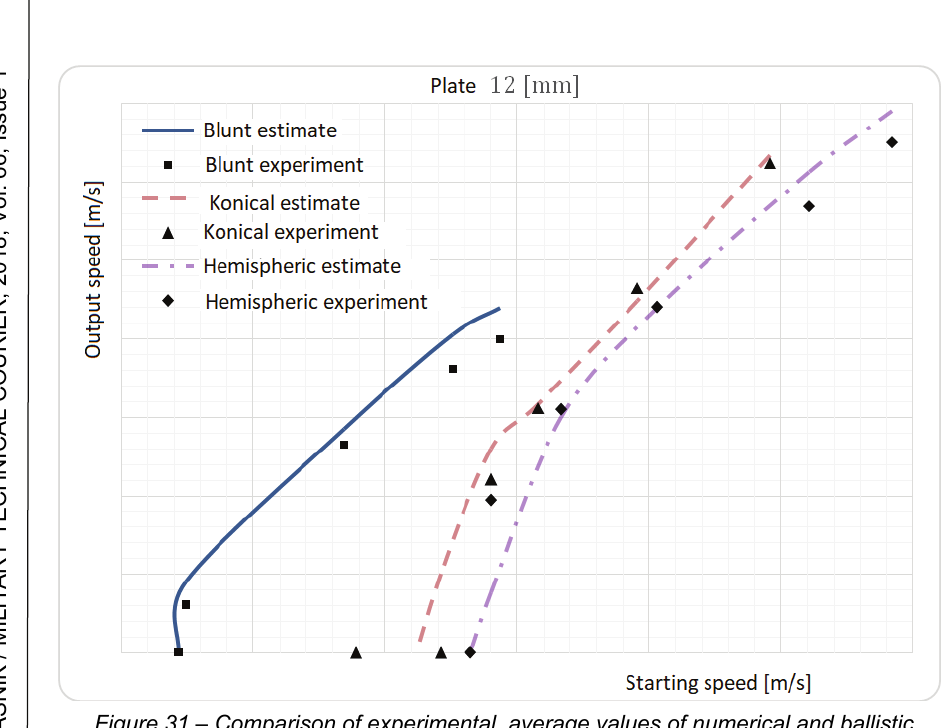
Figure 31 – Comparison of experimental, average values of numerical and ballistic boundary velocities